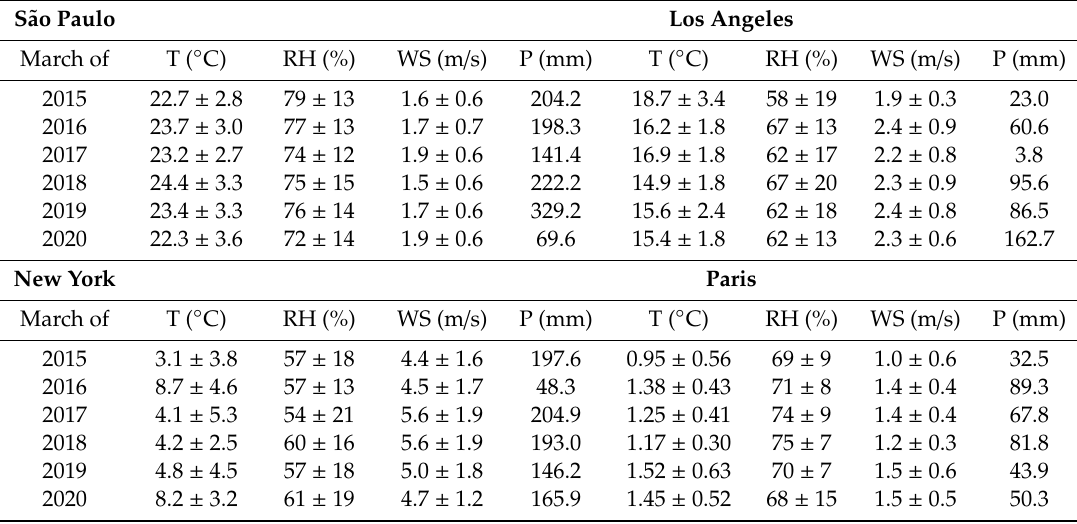
Table 1. Annual average and standard deviation for meteorological parameters for the month of March